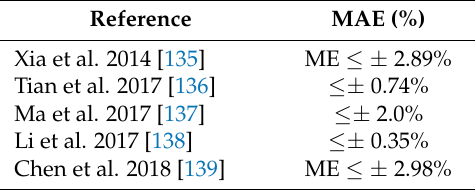
Table 12. MAE/ME of the NLO-based SOC estimation method.